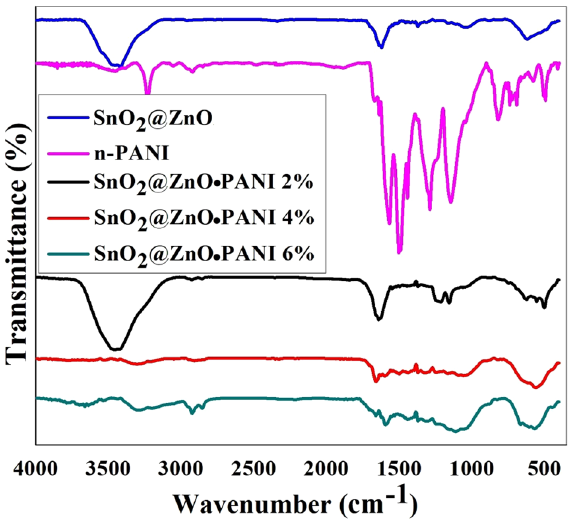
Figure 3. FT-IR spectra for SnO 2 @ZnO nanocomposite, PANI-NPs and different volume ratios of SnO 2 @ZnO. PANI (2%, 4%, and 6%) nanocomposites.